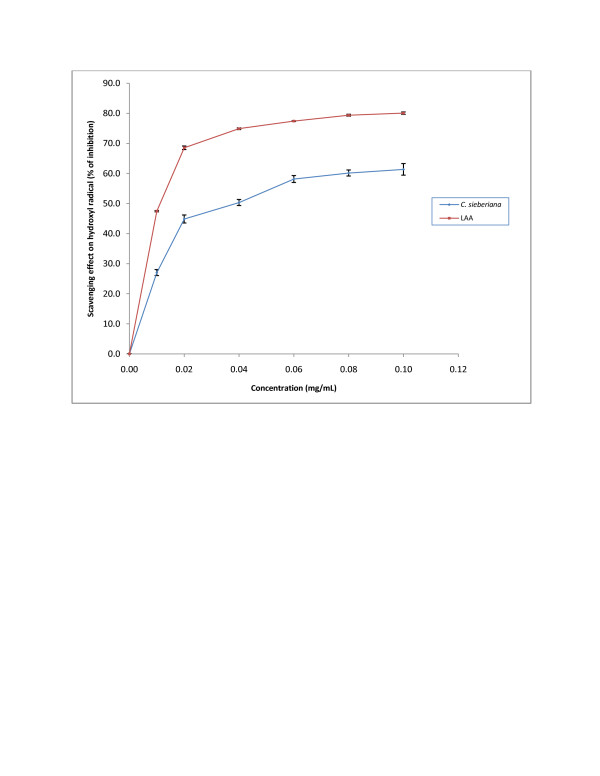
Hydroxyl radical scavenging activity ofC. sieberianaroots bark extract. L-ascorbic acid (LAA) was used as a reference compound. Results are means ± SEM of n = 3.